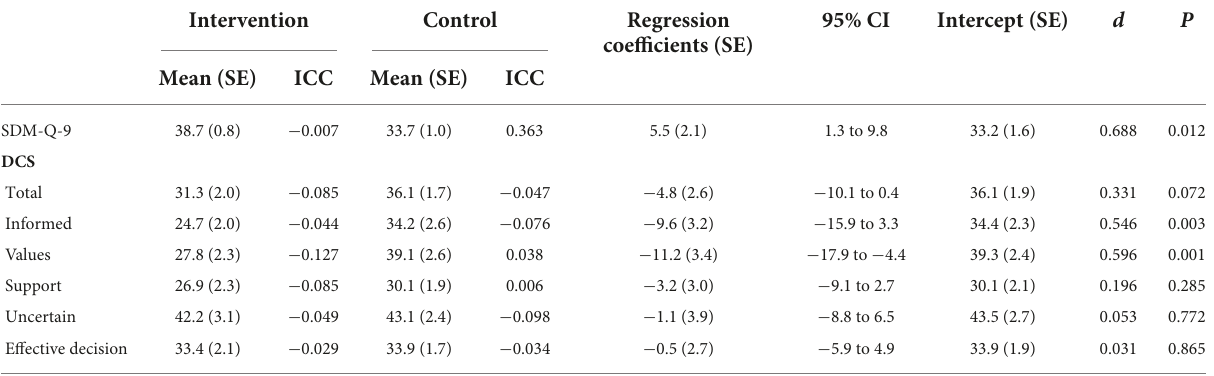
TABLE 2 Comparison of primary outcomes after first visits. Intervention